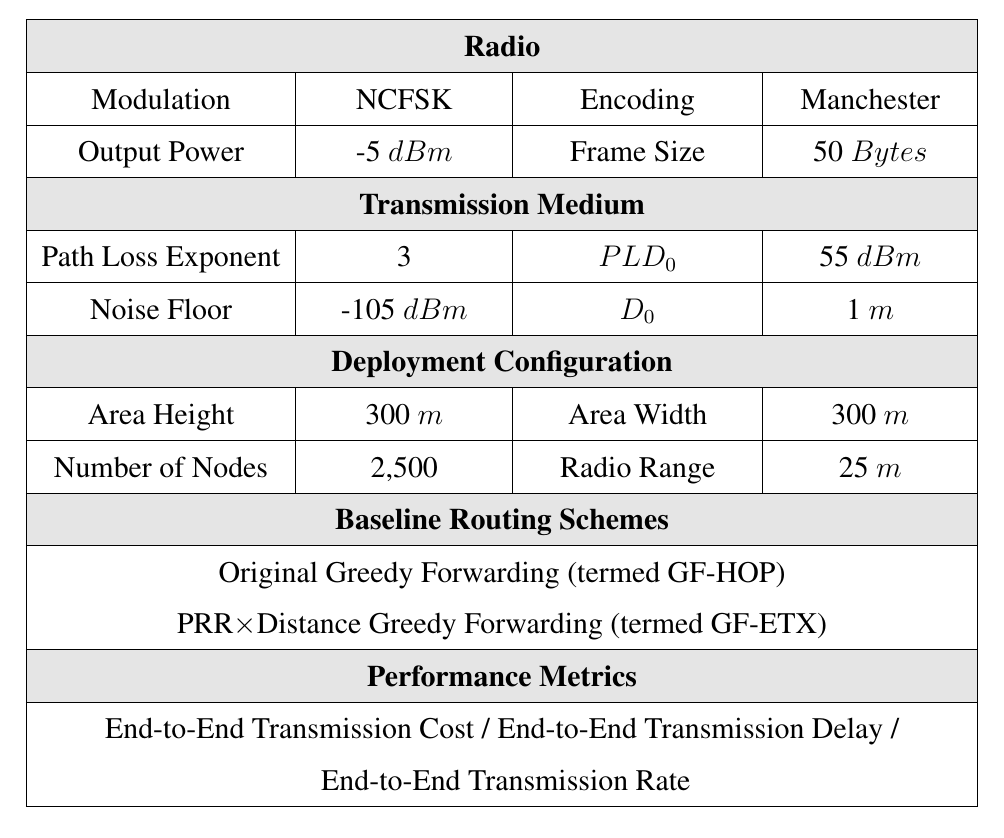
Table 3. Simulation